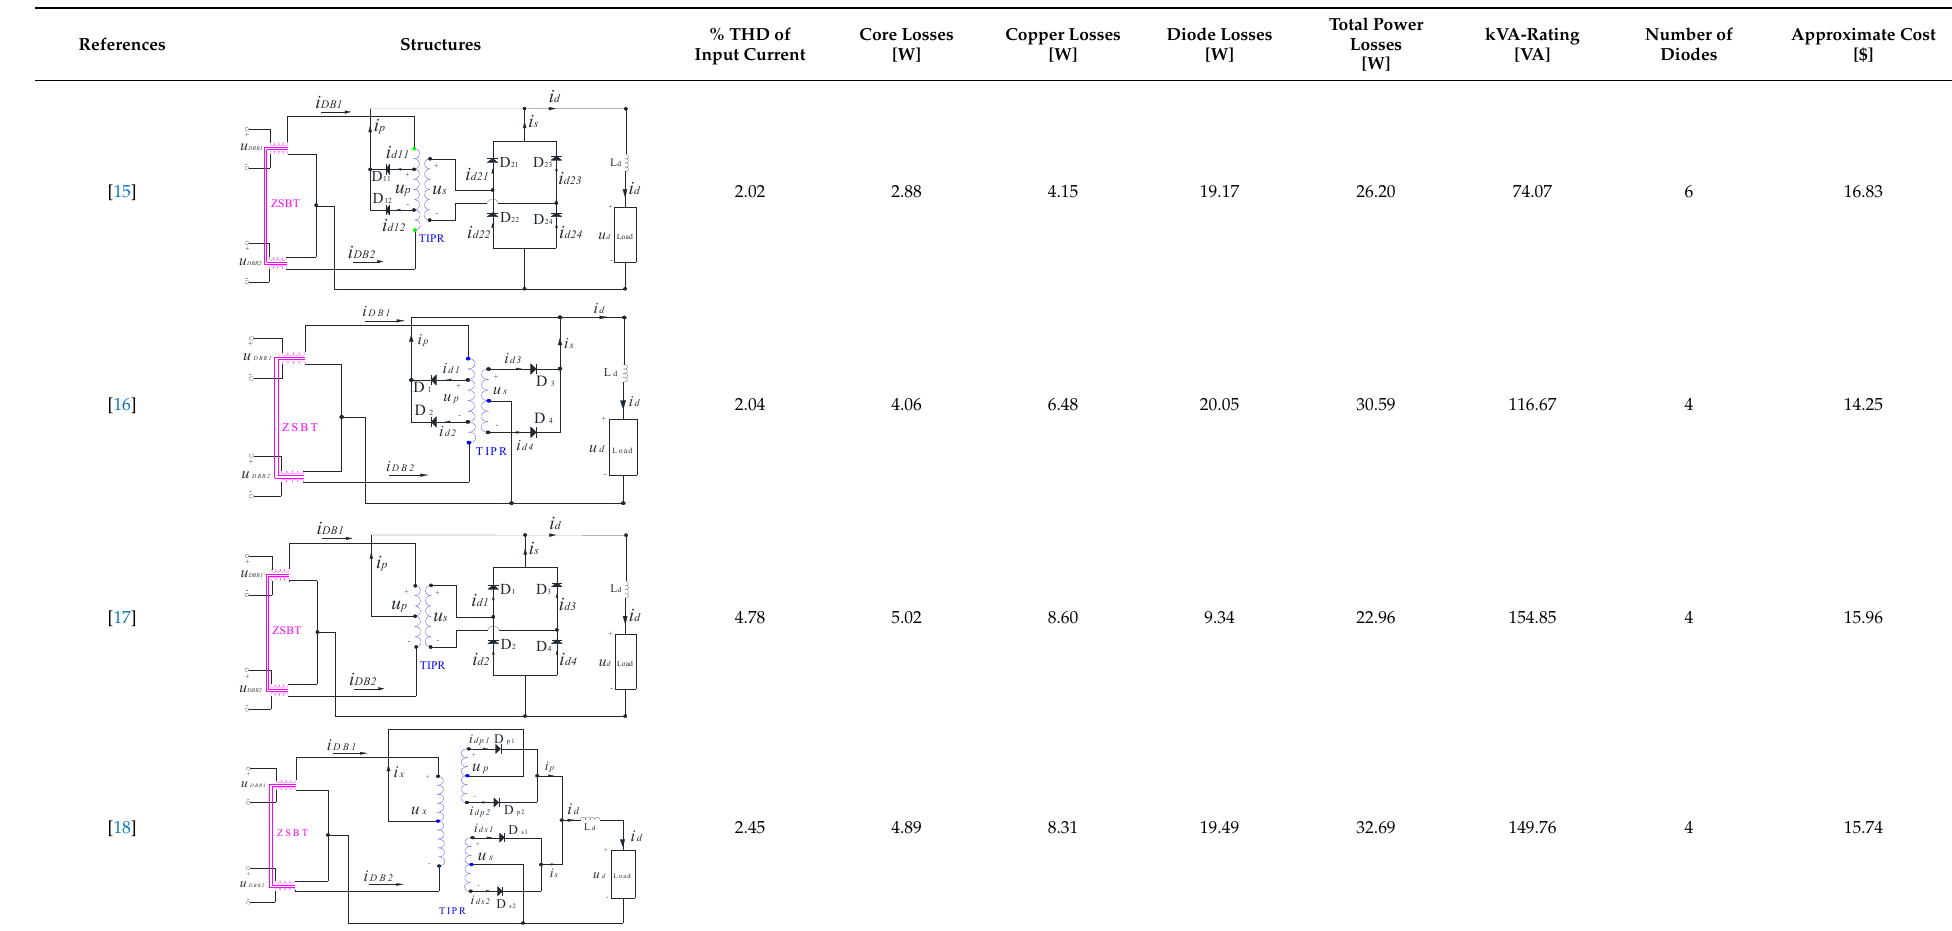
Table 3. Comparison of different PDTs for a 10-kW load.